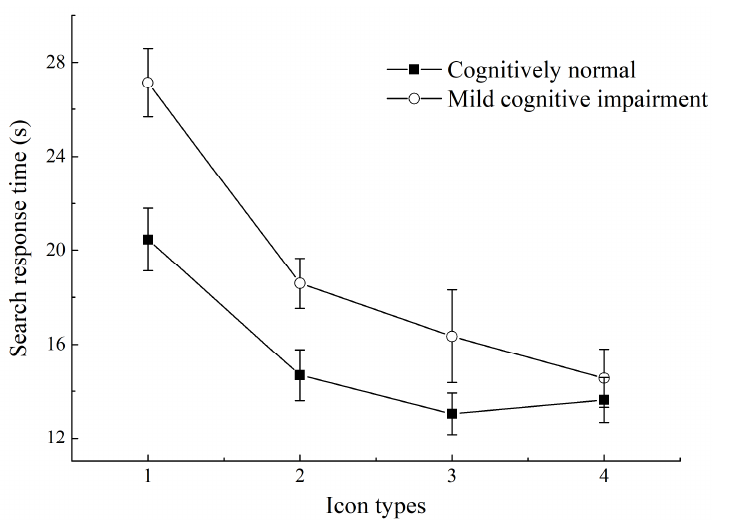
Figure 4. Search response time for different icon types in older adults with different cognitive levels. (1) Flat icons (FIs); (2) skeuomorphic icons (SIs); (3) FIs plus text; (4) SIs plus text.